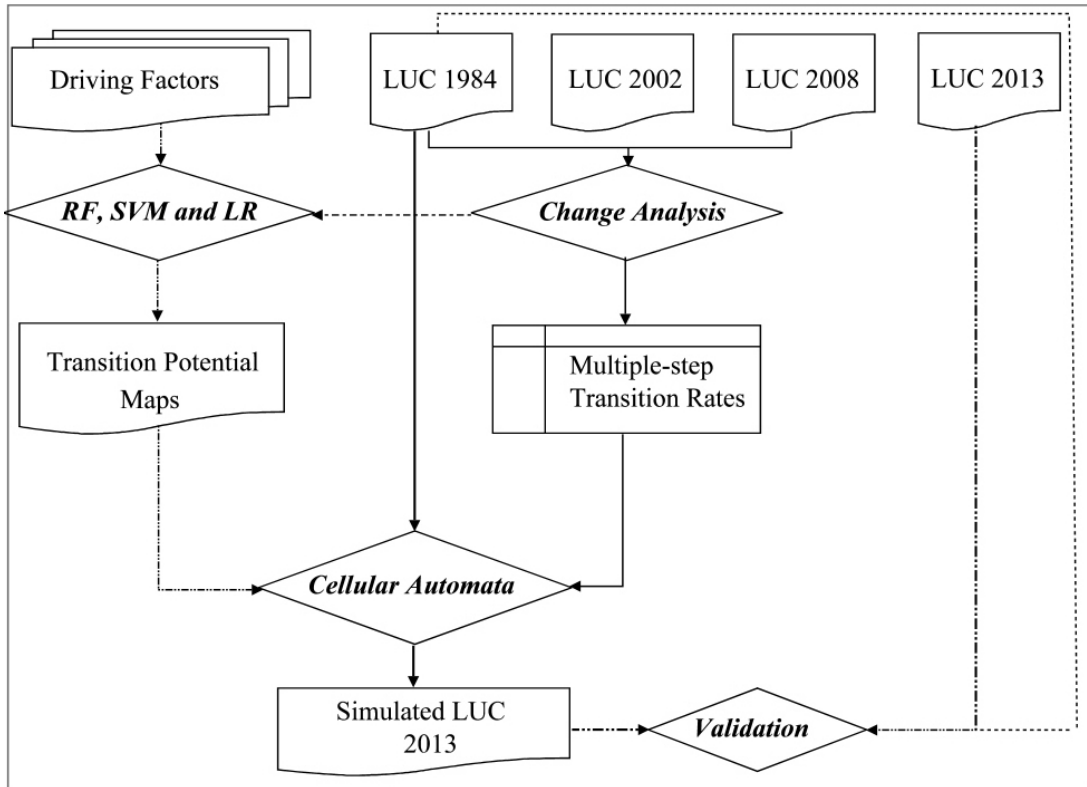
Figure 4. Random forest-cellular automata (RF-CA) model. Note LUC refers to land